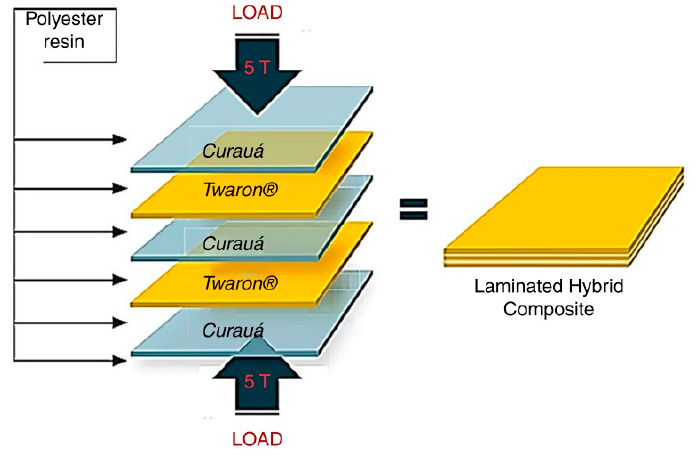
Figure 21. The schematic representation of caraua reinforced aramid fabric hybrid composites.